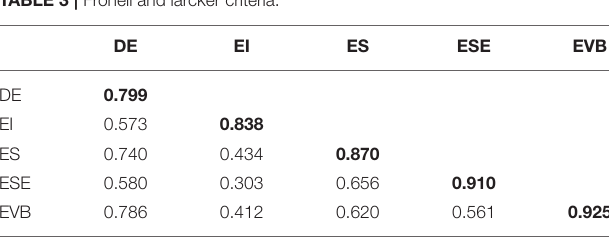
TABLE 3 | Fronell and larcker criteria.